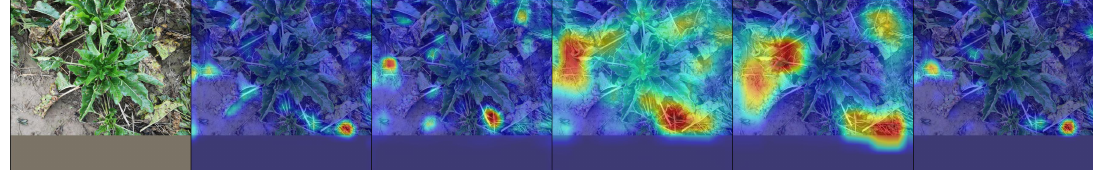
Figure 7. Saliency visualization of all network architectures. (column 1) original image. (column 2–6) Grad-CAM++ for AlexNet, VGG-16, ResNet-101, DenseNet-161, and SqueezeNet1_1, respectively. The ground truth label is NPK_.